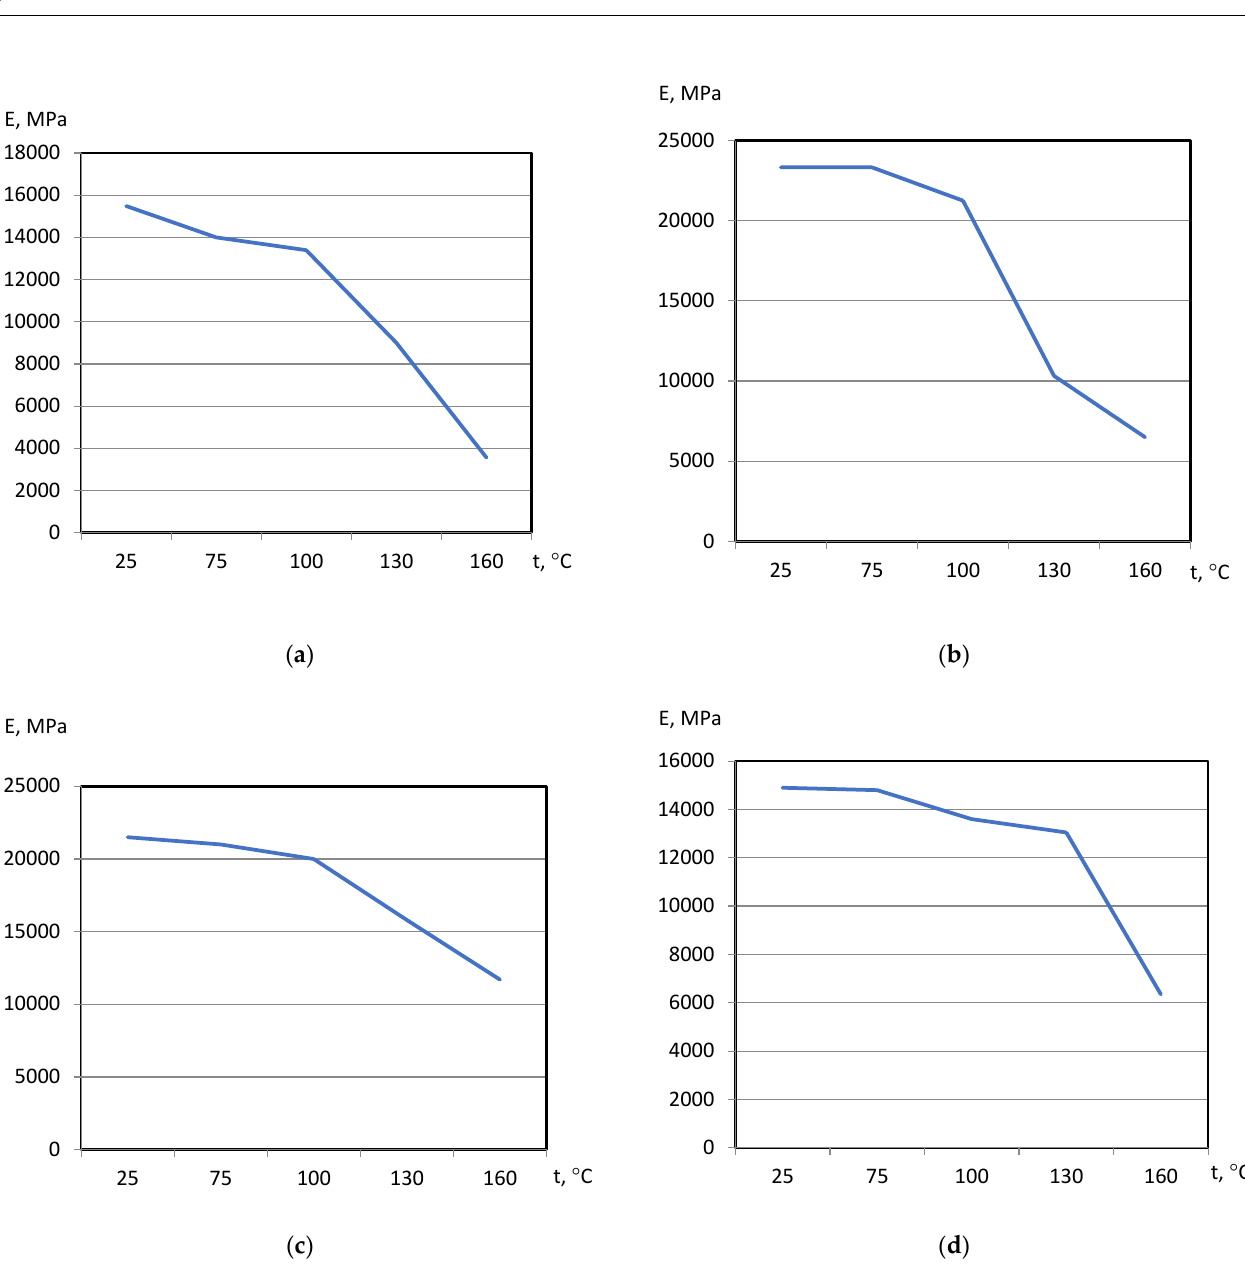
Figure 6. FRPs’ MoE under heating curves: FRPs’ TE curves: ( a ) EP+T23, ( b ) EP+T23+FA, ( c ) EP+T23 after T-relax, ( d ) EP+T23+FA after TR.